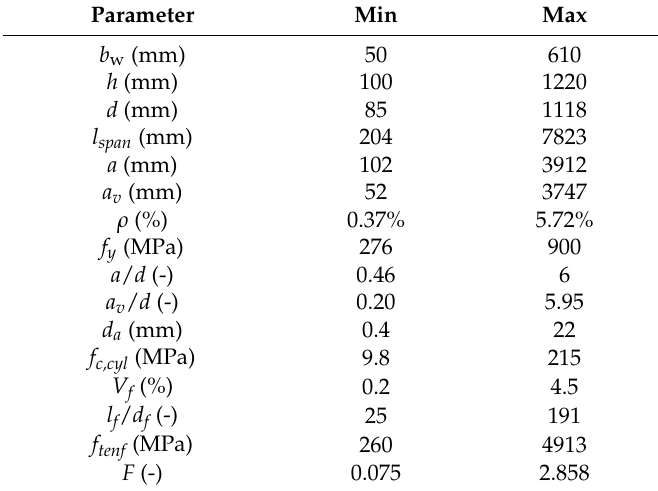
Table 2. Ranges of parameters in